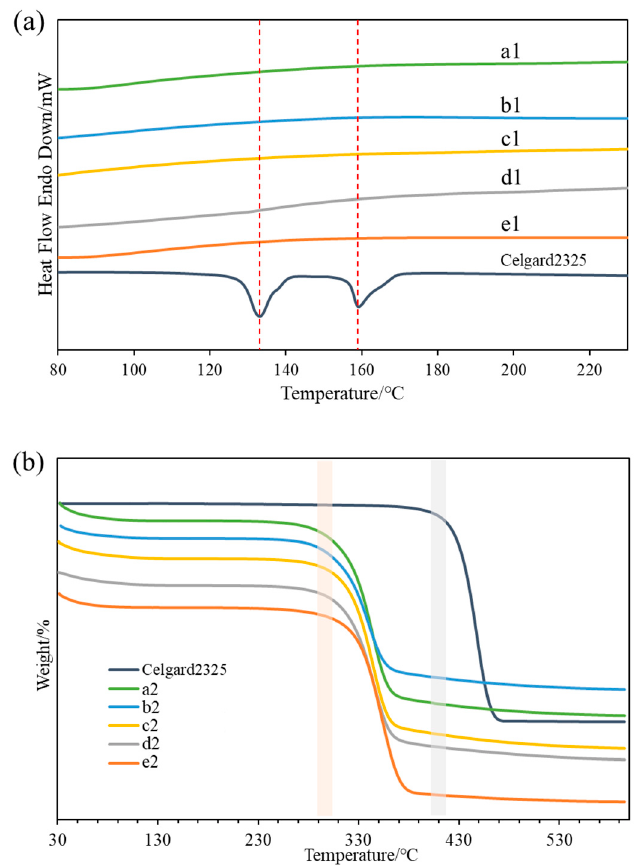
Figure 7. The ( a ) DSC and ( b ) TGA curves of Celgard2325 and the cellulose membranes before and after the homogenization.